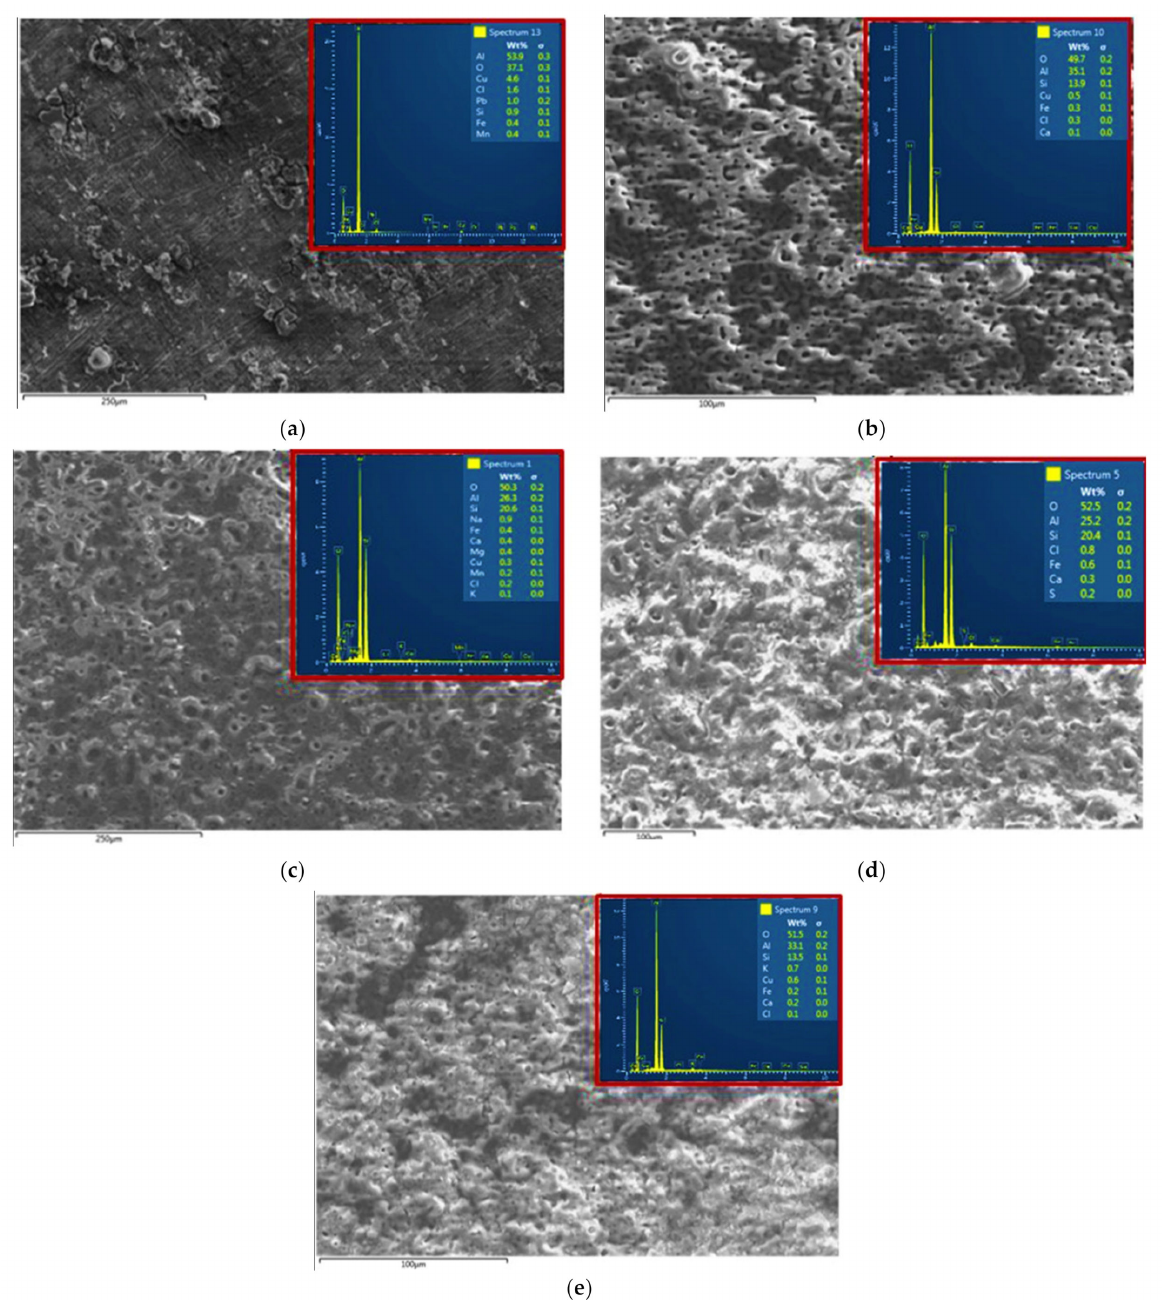
Figure 5. SEM images and EDS analysis of PEO-coated AA2014 samples after the corrosion test: ( a ) BM, ( b ) BP50, ( c ) SiC/UP30, ( d ) SiC/BP50_1000, and ( e )